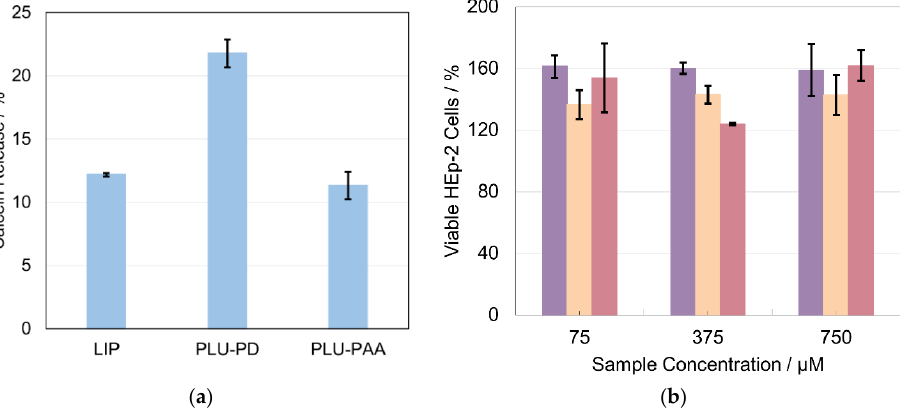
Figure 5. ( a ) Calcein release of LIP, PLCs with 10% PLU-PD and PLCs with 10% PLU-PAA after 2 h of incubation at 42 °C and pH = 7. Results are expressed as mean ± standard deviation (SD), n = 3. ( b ) Viability of HEp-2 cells after 24 h of incubation with LIP (purple bars), PLCs of 10% PLU-PD (orange bars) and PLCs of 10% PLU-PAA (pink bars). Results are expressed as mean ± standard deviation (SD), n = 3.